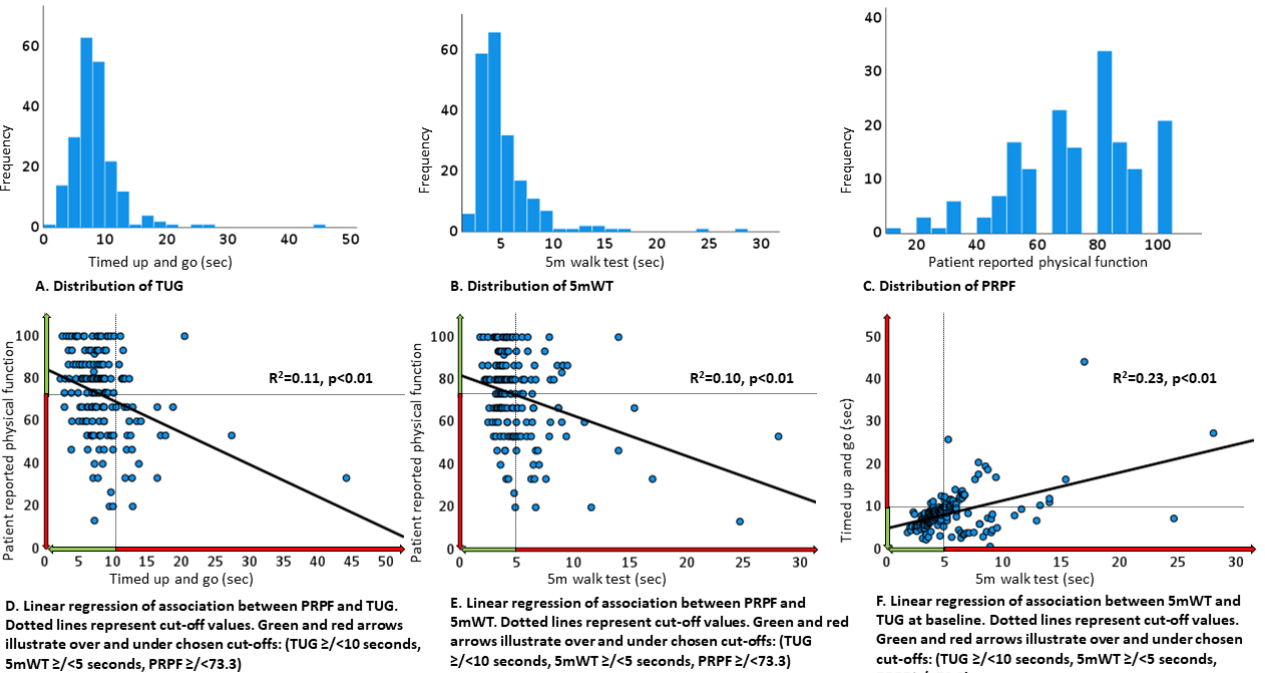
Figure 3. Physical performance tests and patient-reported physical function at baseline.